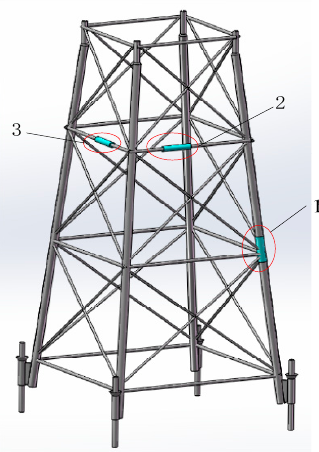
Figure 4. Installation position of grouting clamp.